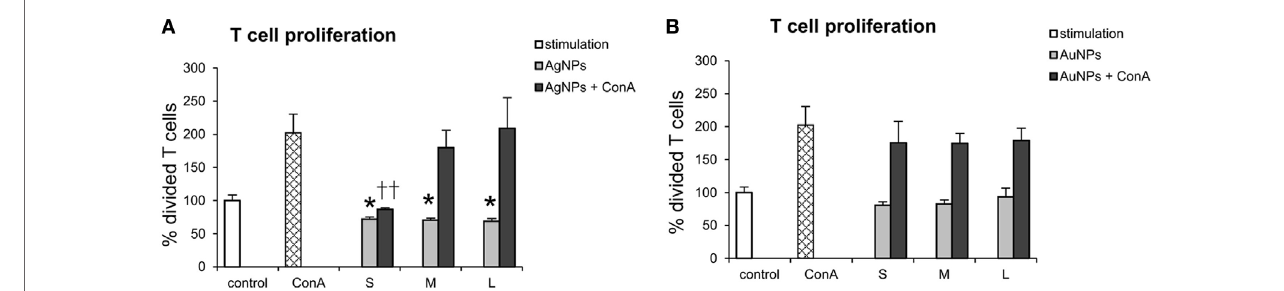
FigUre 12 | Direct effect of nanoparticles (NPs) on proliferation of T cells. T cell cultures with or without concanavalin A (ConA) were cultured with 2.5 µg/ml of (a) 10 nm (S), 37 nm (M), 59 nm (L) TA-AgNPs and (b) 10 nm (S), 34 nm (M), 62 nm (L) TA-AuNPs for 72 h. Each bar represents the mean from 3 experiments ( N = 3) ± S.E.M. *Significant differences with p ≤ 0.01, †† p ≤ 0.01 calculated in relation to concanavalin A-treated